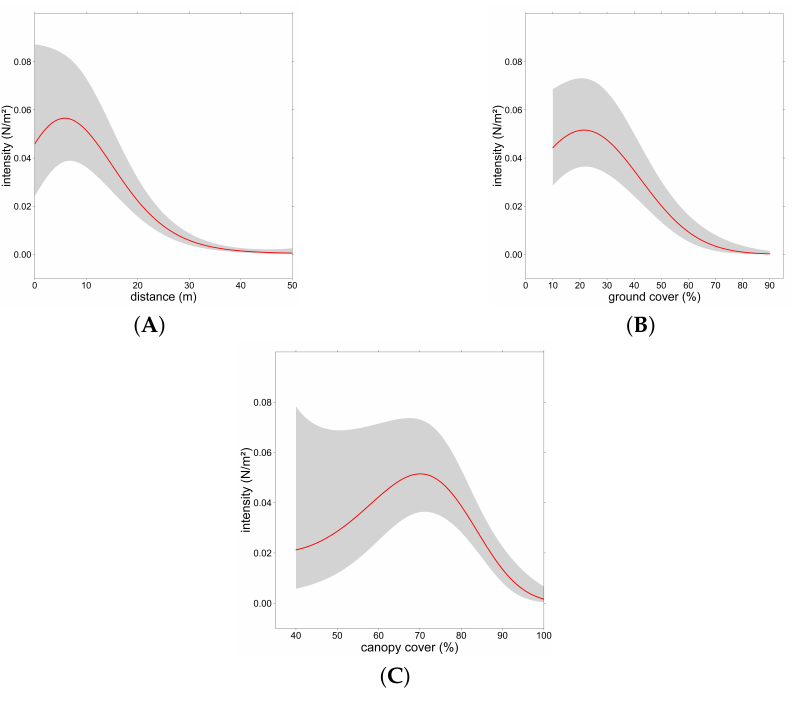
Figure 5. Effect of covariates (good condition) on regeneration of V. odorata. ( A ) Effects of distance to next source on seedlings density; ( B ) Effects of ground cover on seedlings density; ( C ) Effects of canopy cover on seedlings density.